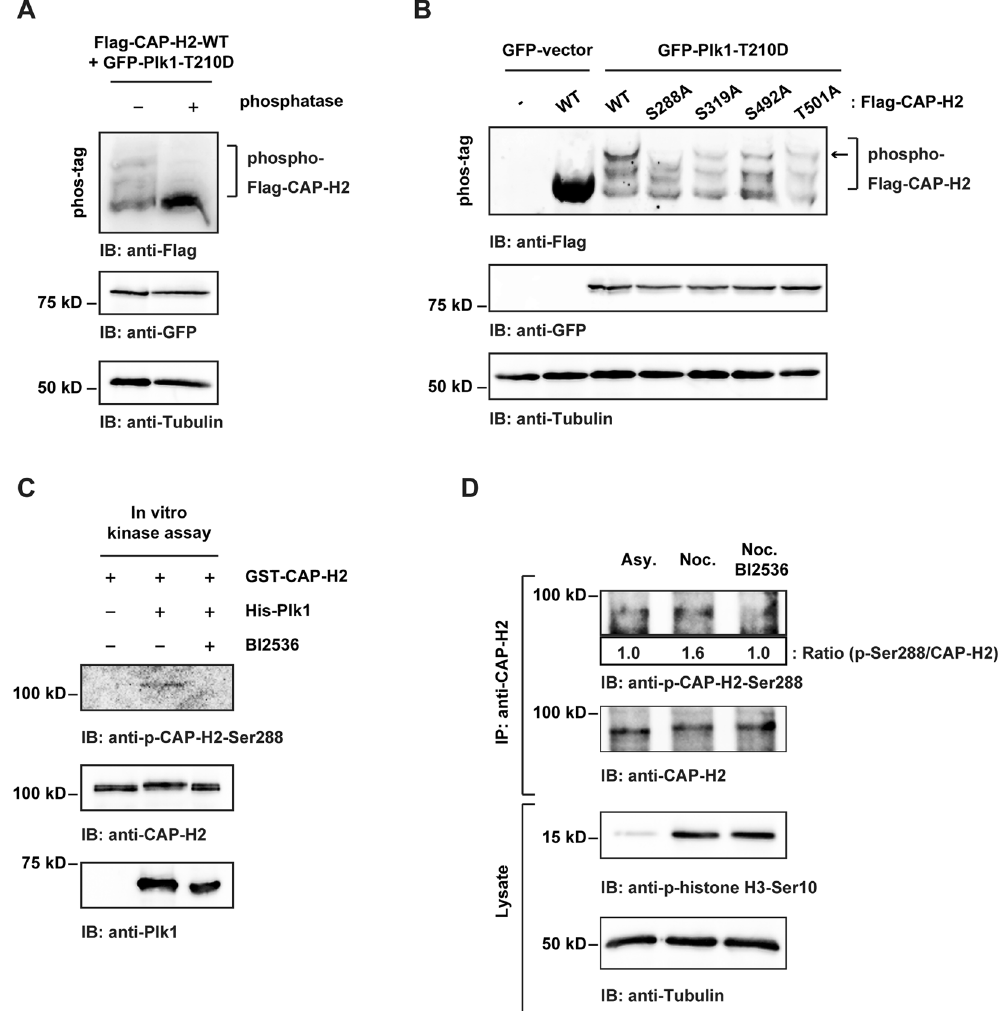
Figure 4. Identification of Ser288 of CAP-H2 as a Plk1 phosphorylation site. ( A ) 293 cells were co-transfected with Flag-CAP-H2 and GFP-Plk1-T210D. Cell lysates were incubated in the absence or presence of lambda protein phosphatase. The lysates were subjected to phos-tag SDS-PAGE and immunoblot analysis. ( B ) 293 cells were co-transfected with indicated plasmids. Cell lysates were subjected to phos-tag SDS-PAGE and immunoblot analysis using indicated antibodies. Hyper phosphorylated form of Flag-CAP-H2 (red arrow) was diminished in S288A mutant. ( C ) Recombinant GST-CAP-H2 was incubated with ATP in the absence or presence of His-Plk1 and BI2536. The reaction products were analyzed by immunoblotting with the indicated antibodies. ( D ) HeLa cells were arrested at mitosis by nocodazole and then were treated with BI2536 for 2 h. The lysates were subjected to immunoprecipitation with anti-CAP-H2. The lysates and immuneprecipitates were immunoblotted with the indicated antibodies. A ratio of p-CAP-H2-Ser288/CAP-H2 was determined by the densitometric analysis using Fusion-CAPT-Software. The ratio of p-CAP-H2-Ser288/CAP-H2 in asynchronous cells was defined as